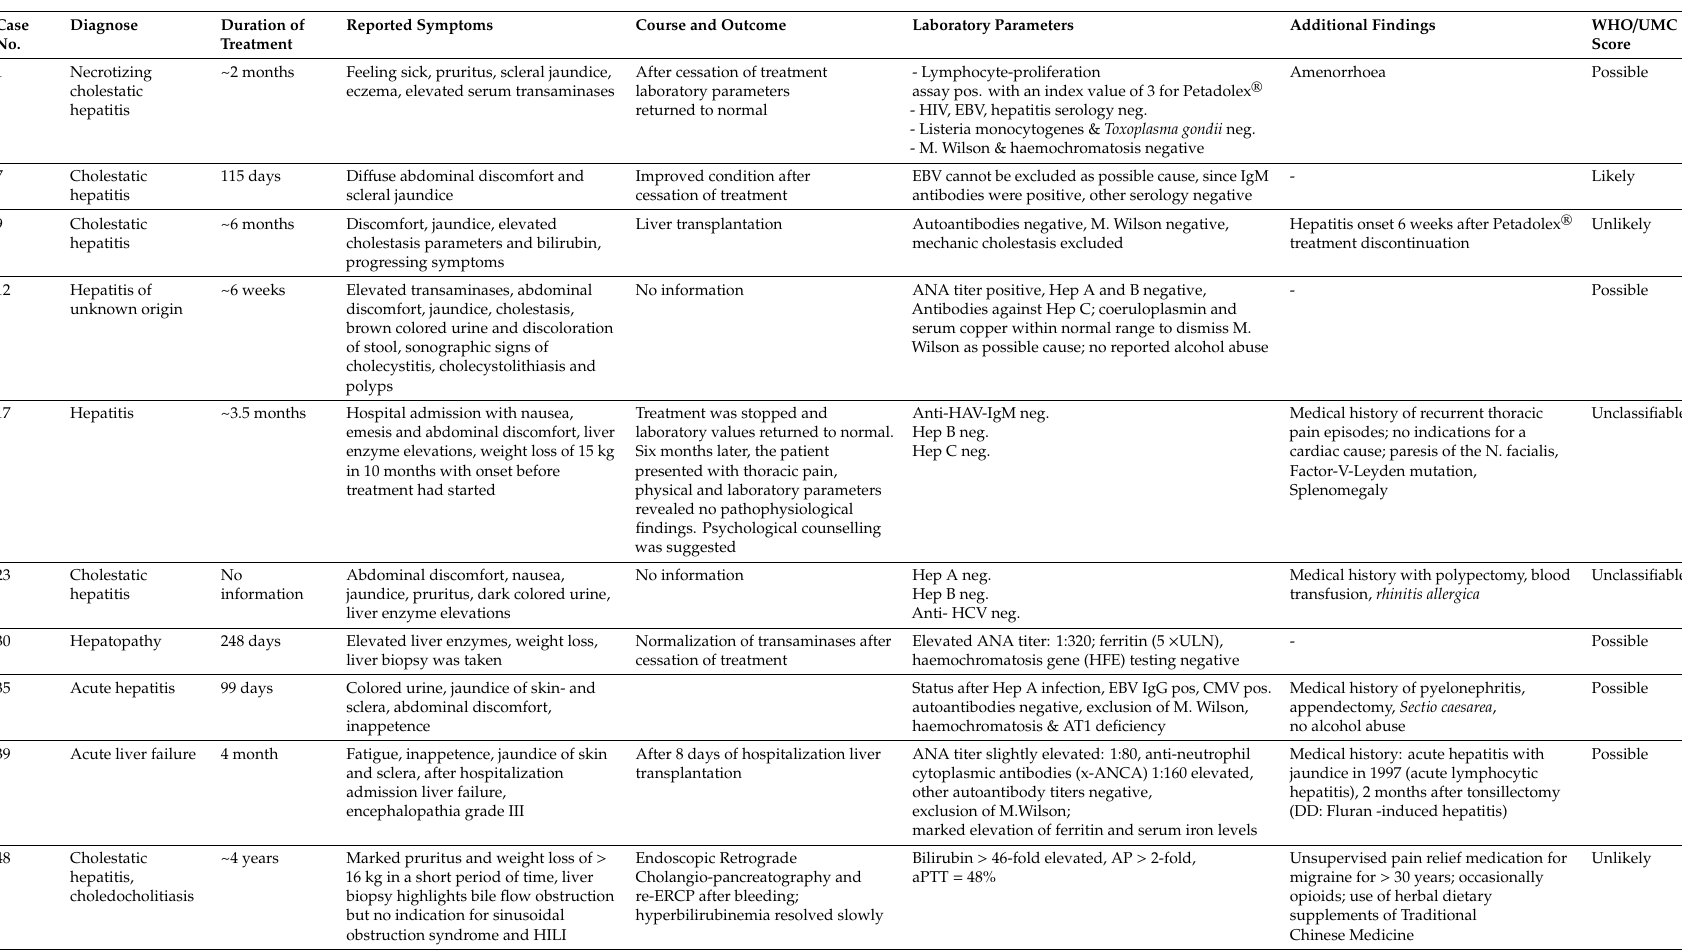
Table 3. A summary of 10 severe HILI cases in association with Petadolex ®